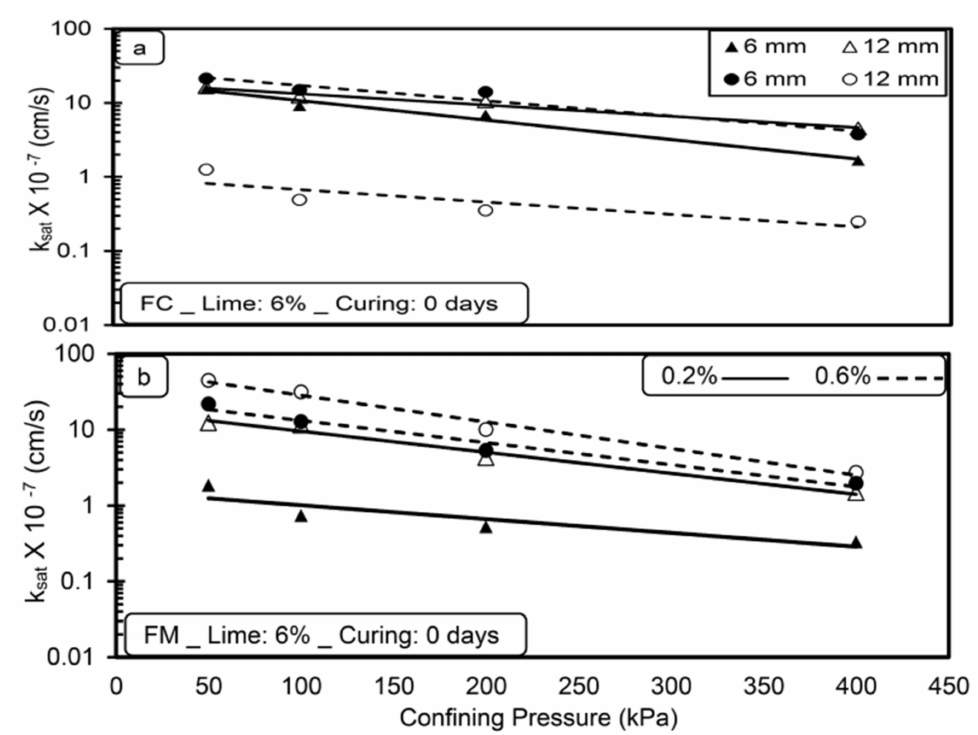
Figure 4. Variations in saturated hydraulic conductivity (k sat ) with confining pressure ( a ) FC ( b ) FM with lime treatment (without